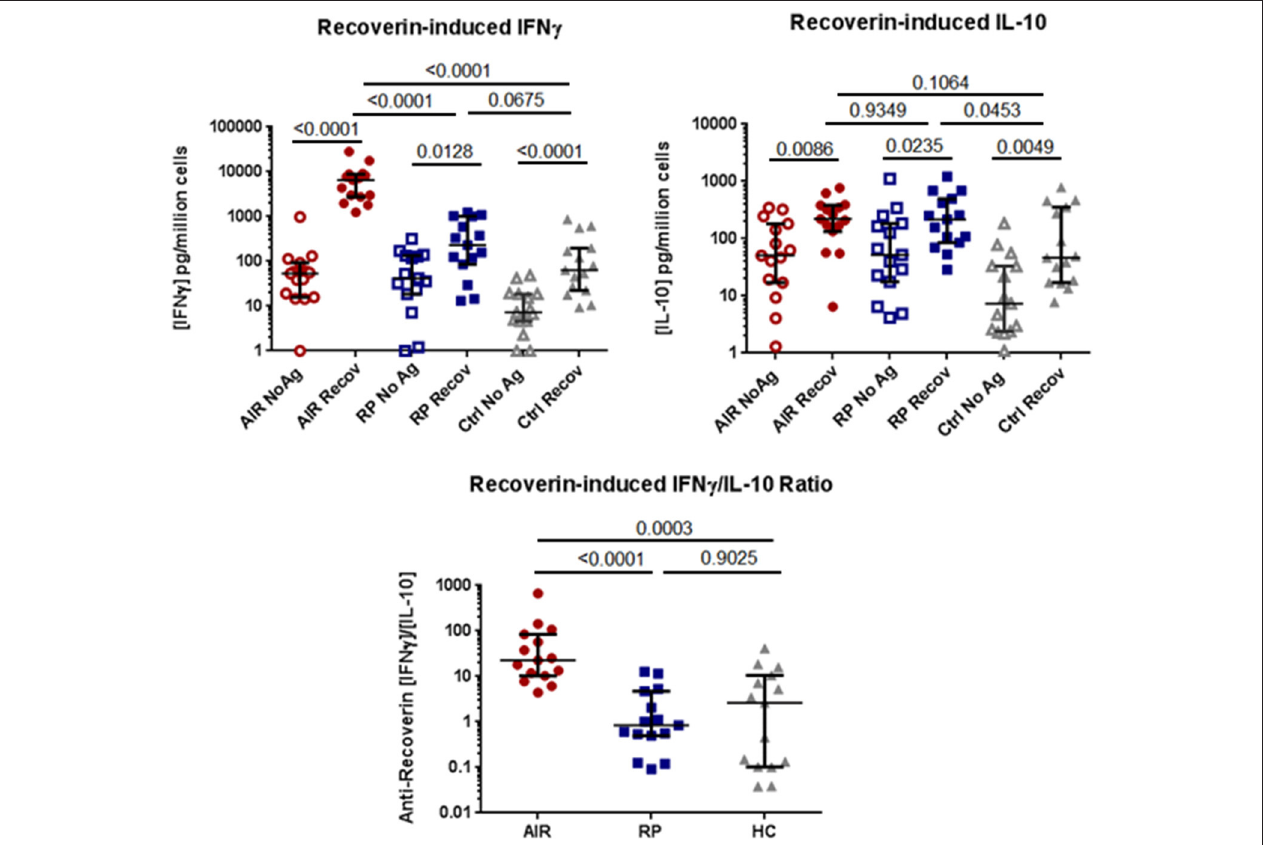
FIGURE 3 | Comparison of PBMC cytokine production in response to recoverin. Isolated PBMC from AIR patients ( n = 15), RP patients ( n = 15) and healthy controls ( n = 14) were cultured for six days in the presence or absence of 2.5 µ g/mL of recombinant human recoverin. Culture supernatants were collected and the levels of released IFN γ and IL-10 were determined by commercial sandwich ELISA. Each dot represents the mean cytokine level from triplicate wells for each individual. The group median and 95% confidence intervals are shown with horizontal lines and hash marks, respectively. Exact P- values determined by non-parametric Mann-Whitney tests are expressed below the title of each graph. The ratio of IFN γ to IL-10 production for each individual is shown on the lower